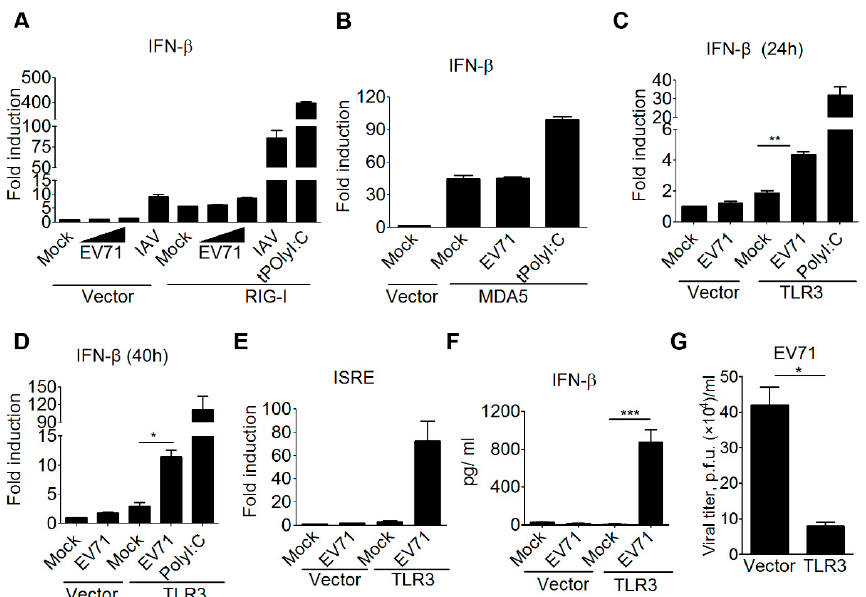
Figure 1. TLR3 detects EV-A71 infection to trigger type I IFN-mediated antiviral immunity. (A)